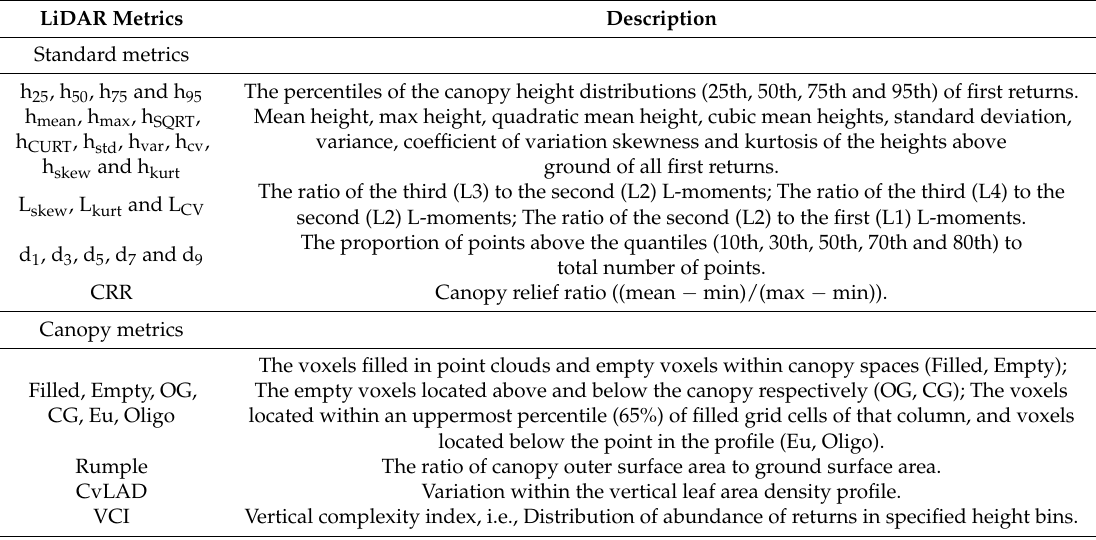
Table A1. Summary of Light Detection and Ranging (LiDAR)